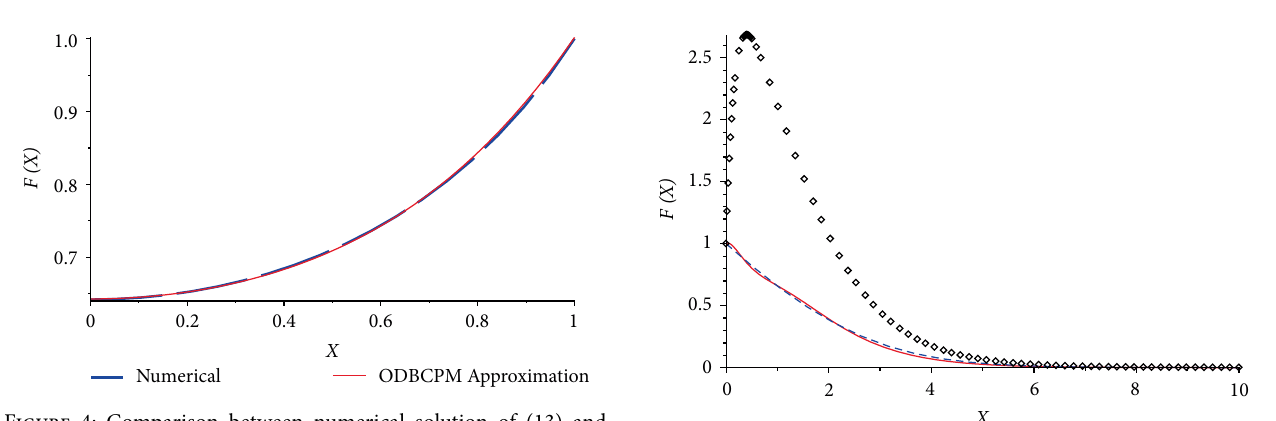
Figure 4: Comparison between numerical solution of (13) and approximate solution (29) for 휀 = 3.